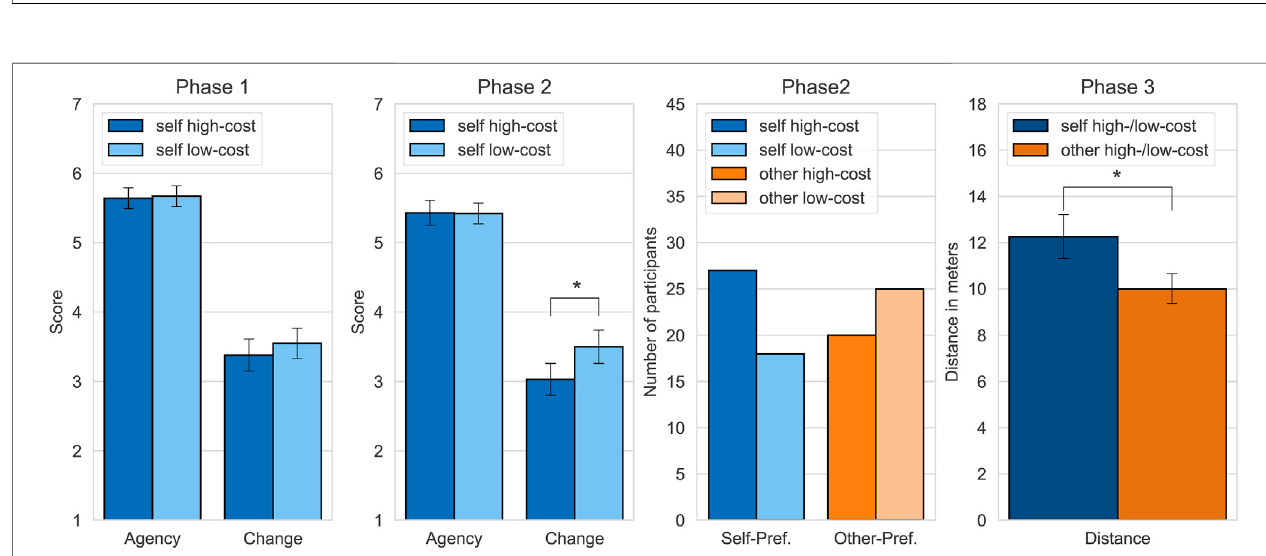
FIGURE 5 | Means and standard errors for the measurements of the perceived similarity, human-likeness, beauty, and eeriness of the high- and low-cost self- avatars and virtual others in phases 1 and 2.